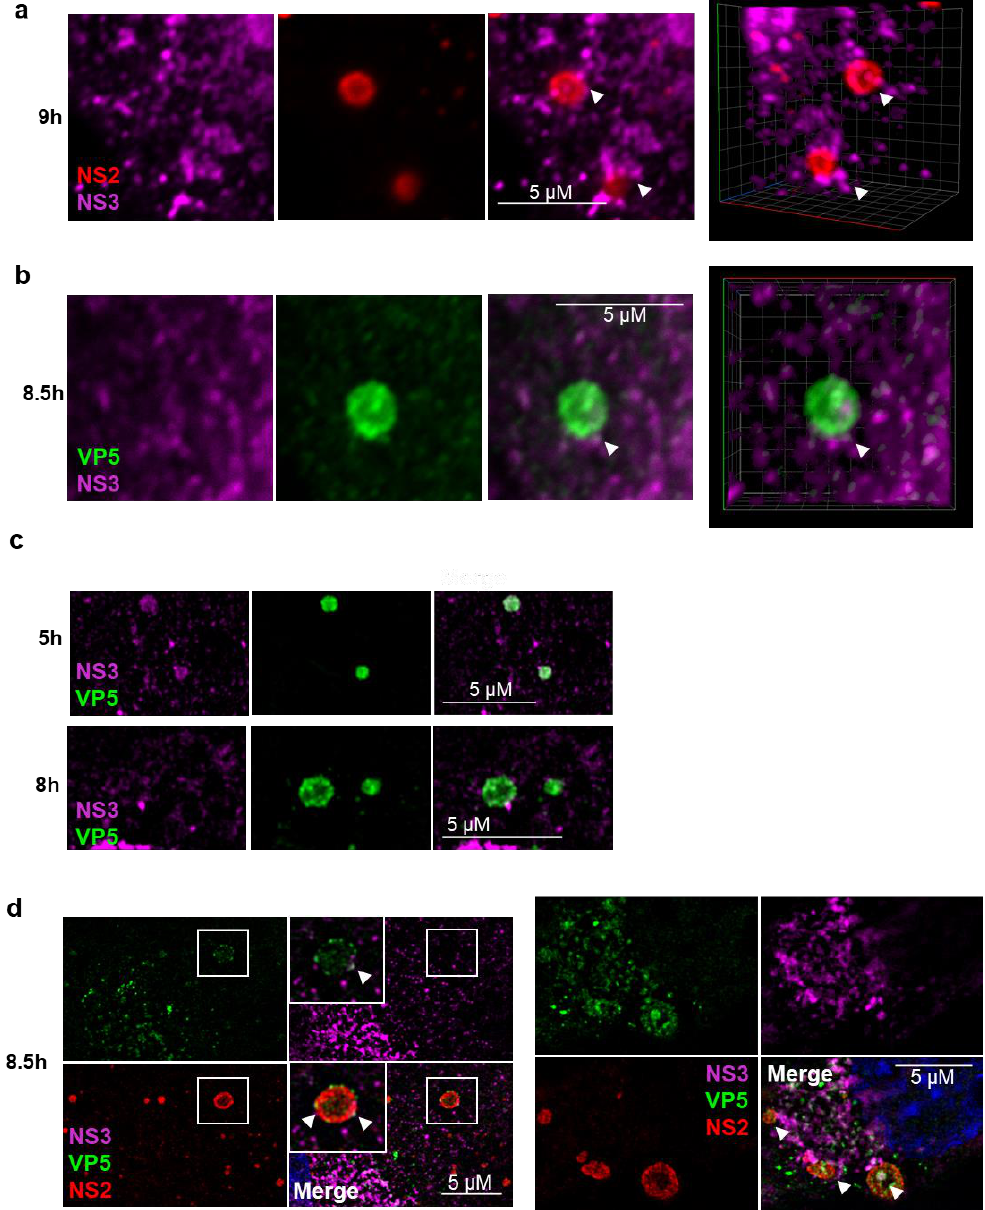
Figure 3. NS3 associates with the periphery of VIBs during the BTV replication cycle and outer capsid protein VP5. Immunofluorescence analysis of the localization of the VIB-specific non-structural protein 2 (NS2) and the non-structural protein 3 (NS3) and the outer capsid protein VP5. ( a ) VIB localization of NS2 (red) and NS3 (magenta) in BTV infected cells 9 h.p.i. (scale bar = 5 µ m). Right panel: 3D projection of the z-stack. ( b ) VIB localization of VP5 (green) and NS3 (magenta) in BTV infected cells 8.5 h.p.i. (scale bar = 5 µ m). Right panel: 3D projection of the z-stack. ( c ) VIB localization of the non-structural protein NS3 (magenta) and the outer capsid protein VP5 (red) at 5 h.p.i and 8 h.p.i. as observed by SIM (scale bar = 5 µ m). ( d ) VIB localization of the non-structural protein NS3 (magenta), NS2 (red), and VP5 (green) at 8.5 h.p.i. as observed by SIM (scale bar = 5 µ m). White arrows indicate peripheral association of NS3 with VIB.